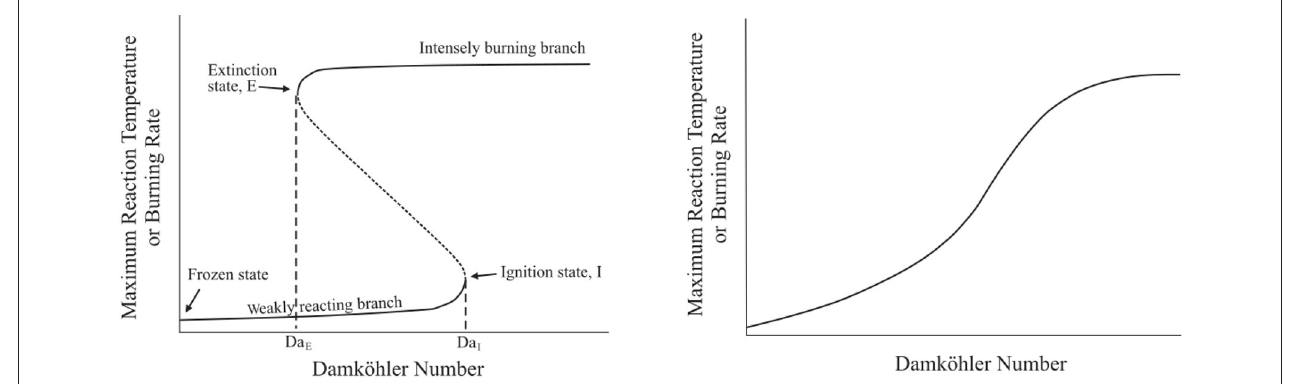
FIGURE 2 | Folded (left) vs. smooth S-Shaped Curves detailing the transitions between weakly reacting, unstable, and fully burning branches in a combustion system. Adapted from Law